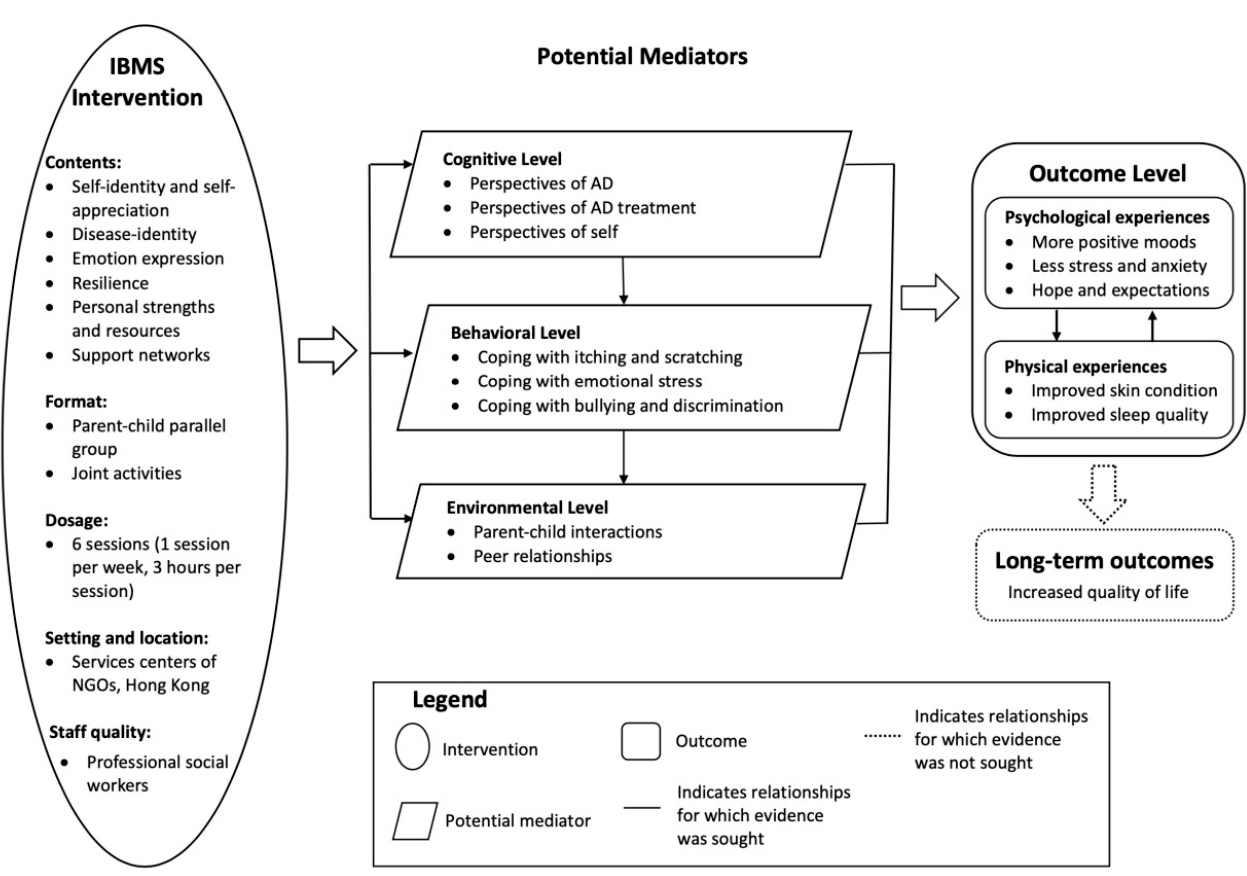
Figure 1. Potential mechanisms underlying the changes in participants’ subjective experiences.